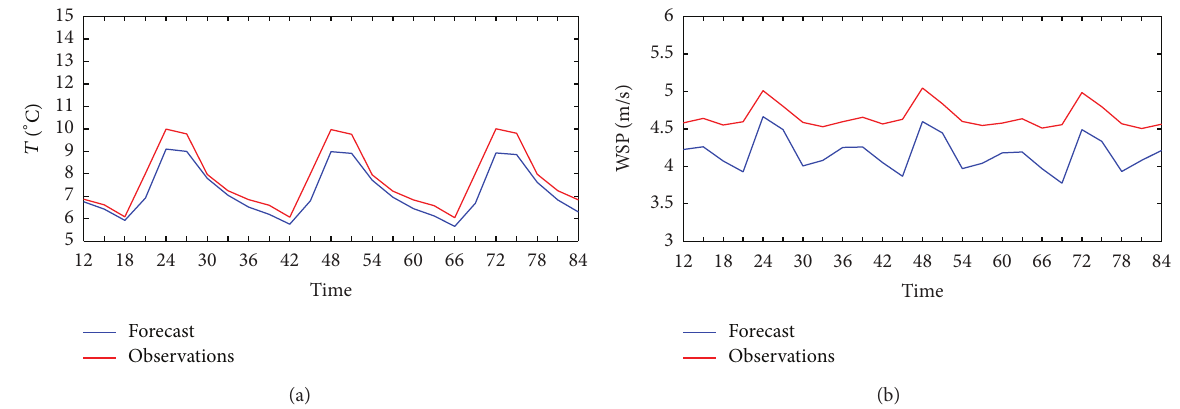
Figure 7: Time series of the forecast and observations for temperature (a) and wind speed (b) in winter.